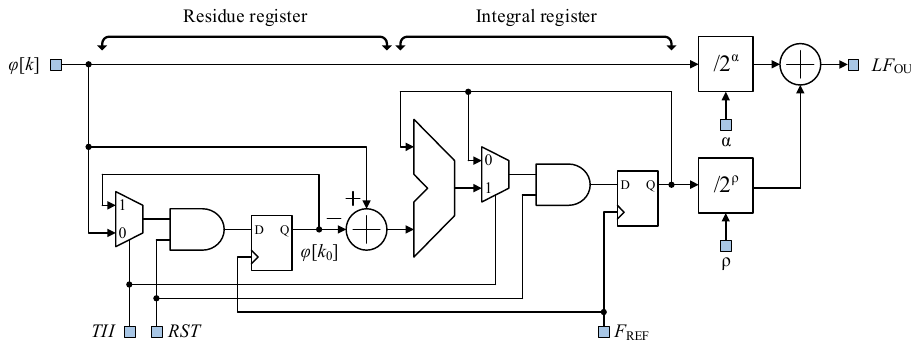
Figure 10. Structure of filter for type-II frequency synthesiser.